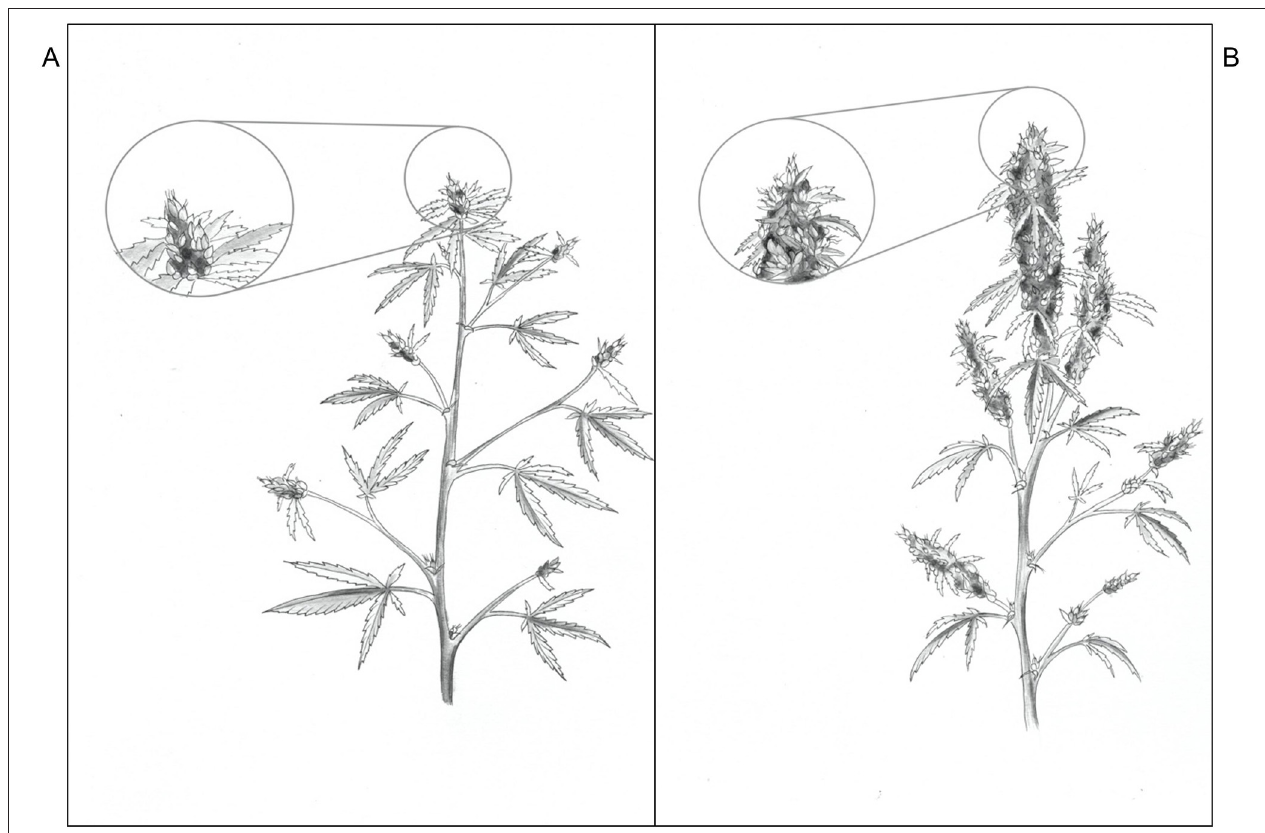
FIGURE 6 | Sketches of Cannabis sativa ‘Stillwater’ plants grown under low (A) and high (B) photosynthetic photon flux density (APPFD), 9 weeks after initiation of 12-h photoperiod (illustrated by Victoria Rodriguez